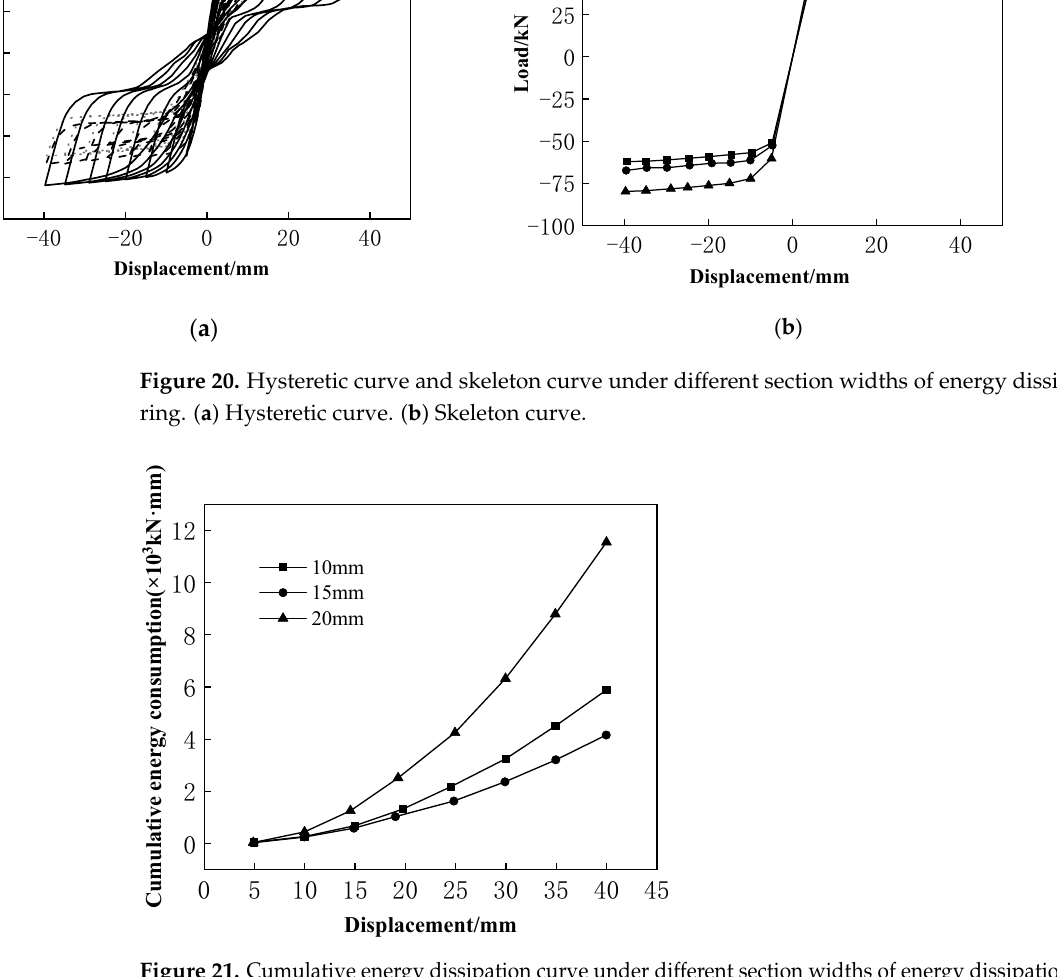
Figure 21. Cumulative energy dissipation curve under different section widths of energy dissipation ring.